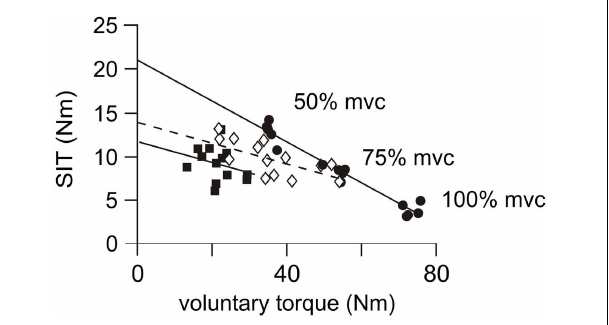
FIGURE 6 | Individual linear regressions from cortical stimulation . Examples of linear regressions for the more-affected side of three patients. Subject 1 (filled circles, solid regression line), displays a good linear relationship ( r 2 = 0.95, p < 0.001) between the magnitude of the voluntary contraction and the amplitude of the superimposed twitch (SIT).Twitch amplitudes are similar in size and appropriately scaled to amplitude of the contraction.This response is similar to those achieved in control subjects and a resting twitch can be reliably estimated from this regression. Subject 2 (open diamonds and dashed regression line) has a moderate linear relationship ( r 2 = 0.45, p = 0.006).Twitch amplitudes are less-consistently scaled to the strength of the contraction.This regression is unlikely to provide an accurate estimation of the resting twitch. Subject 3 (filled squares and solid regression line), has a poor linear regression ( r 2 = 0.08, p = 0.350).There is no relationship between the amplitude of the superimposed twitch and the strength of the voluntary contraction so that a resting twitch could not be